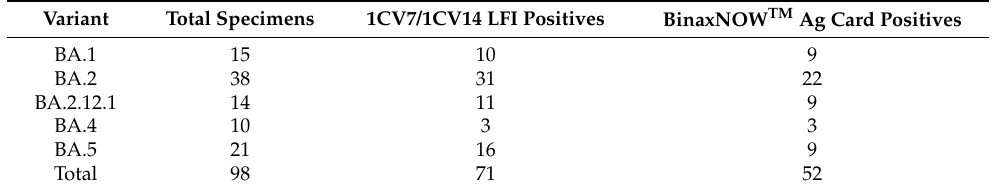
Table 1. Summary of 1CV7/1CV14 LFI and BinaxNOW TM Ag Card SARS-CoV-2 variant testing as seen in Figures